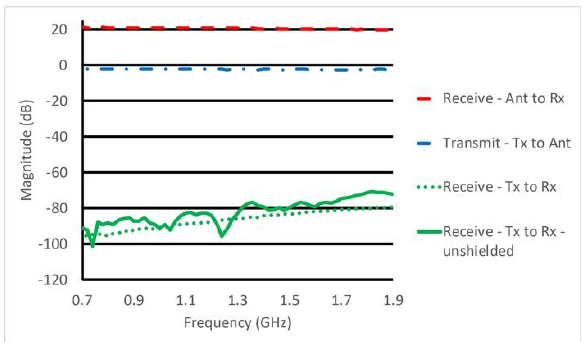
Figure 8. Plots of the switch/amplifier insertion loss (or gain) for the transmission mode (between the Tx and Ant ports), and receive mode (between the Ant and Rx ports). Leakage between transmit and receive ports while operational in the receive mode is shown for the completely shielded housing and the compartmentalized housing without cover,